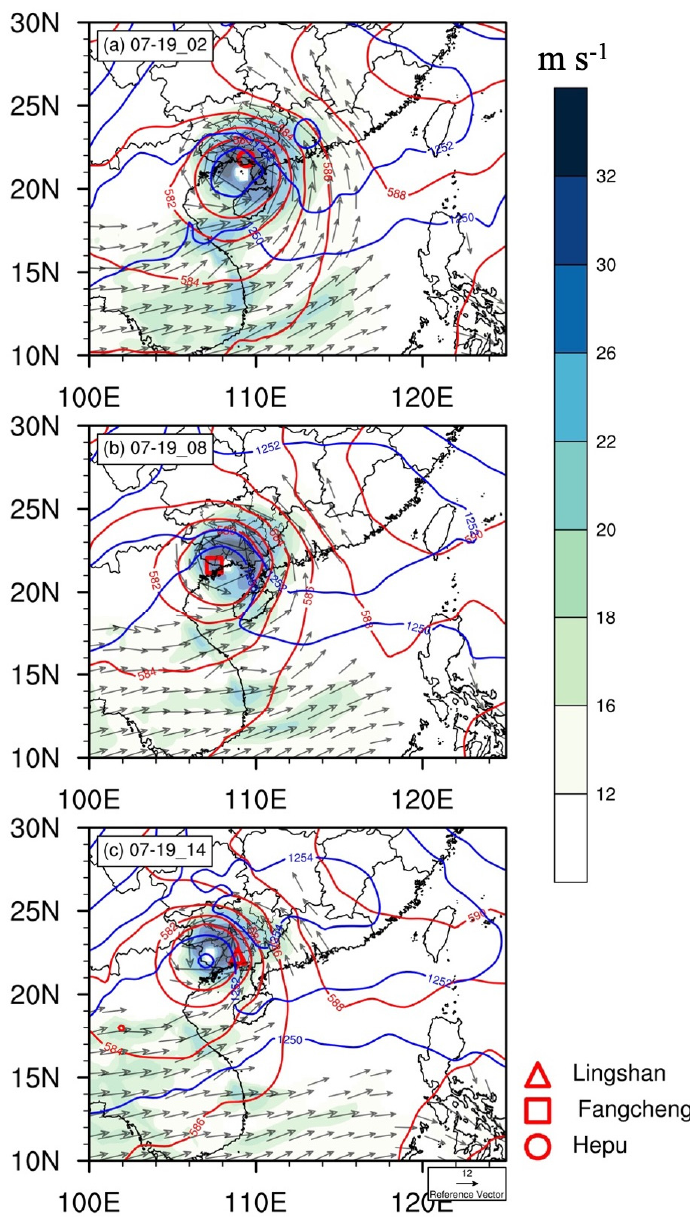
Figure 4. The geographic distributions of 850 hPa wind (shadings and vectors, shown exceeding 12 m s − 1 ), overlaid with 500 hPa (red lines) and 200 hPa (blue lines) geopotential heights (dagpm) from ERA5 at ( a ) 02BST, ( b ) 08BST, and ( c ) 14BST on 19th July, with the red markers denoting three rainstorm centers.